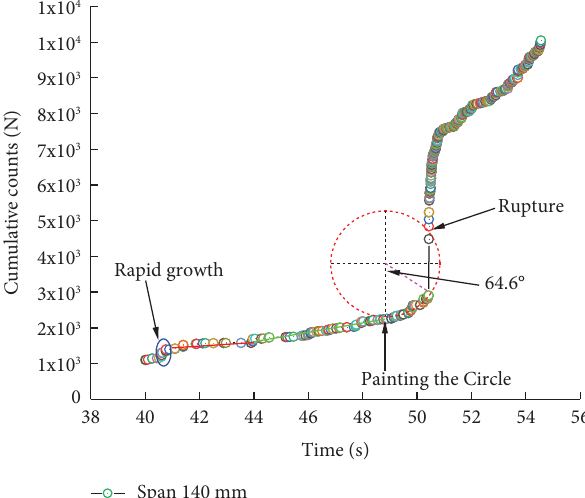
Figure 7: Cumulative peak frequency curve of acoustic